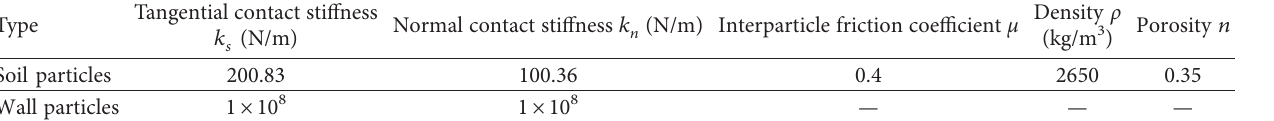
Table 4: Calibrated mesoscopic